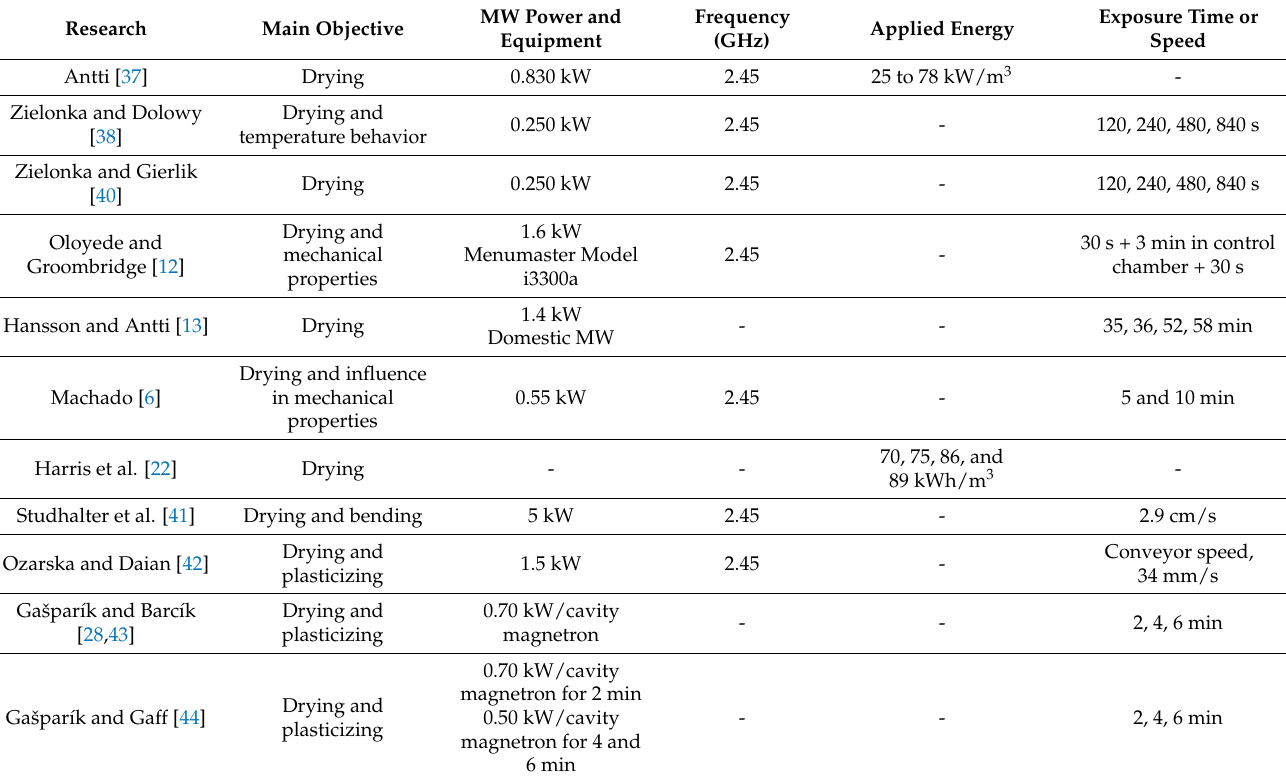
Table 4. Summary of key information in research papers using MW technology for